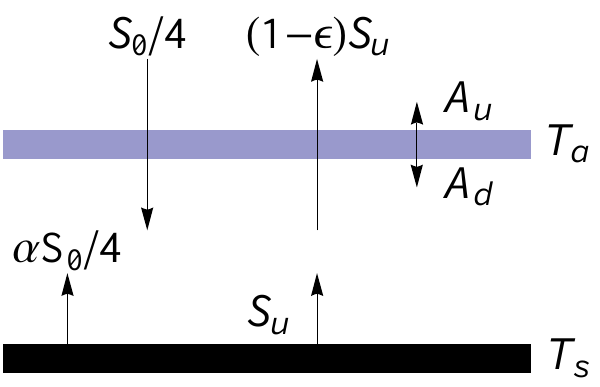
Fig. 11. Simple one-dimensional energy balance model of the earth system with solar constant S 0 and globally integrated incident so- lar radiation S 0 / 4; planetary albedo α ; absorptivity of the atmosphere (cid:15) . S u is long-wave radiation emitted by the earth’s surface, T a ( T s ) are emission temperatures of the atmosphere (surface); A u ( A d ) are upward (downward) long-wave radiation emitted by the atmosphere.